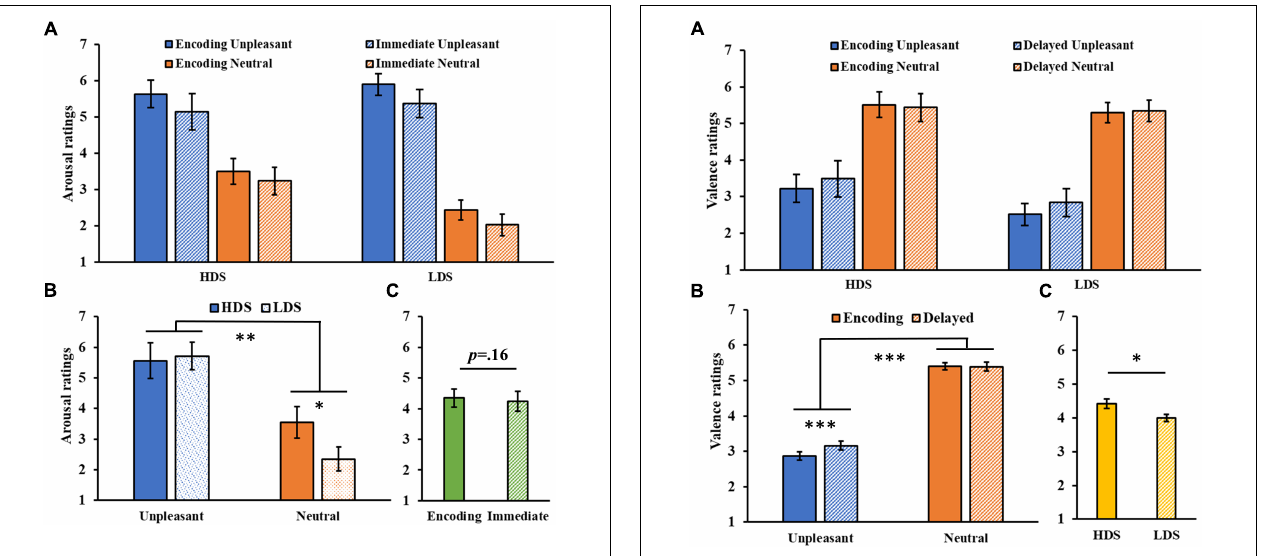
( F 1 , 46 = 9.02, p = 0.004, η 2